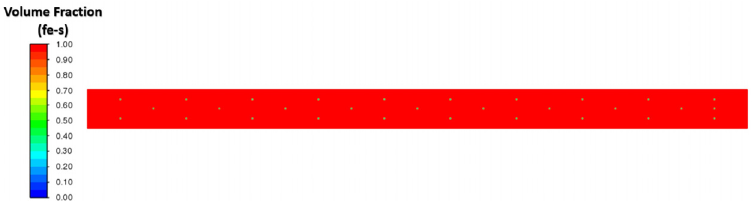
Figure 5. Two-phase model of inclusion and molten steel shown at the beginning of simulation.